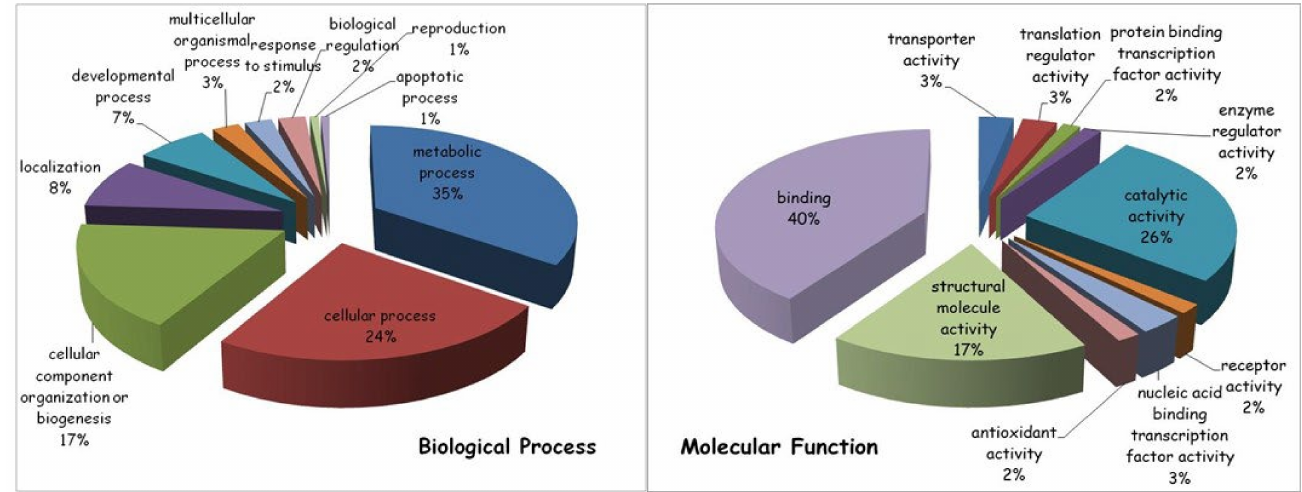
Figure 9. Gene ontology analysis of differentially expressed proteins (ciglitizone-treated cultures versus control cultures) using PANTHER online software. Proteins were classified according to their biological processes ( on the left ) and molecular functions ( on the right